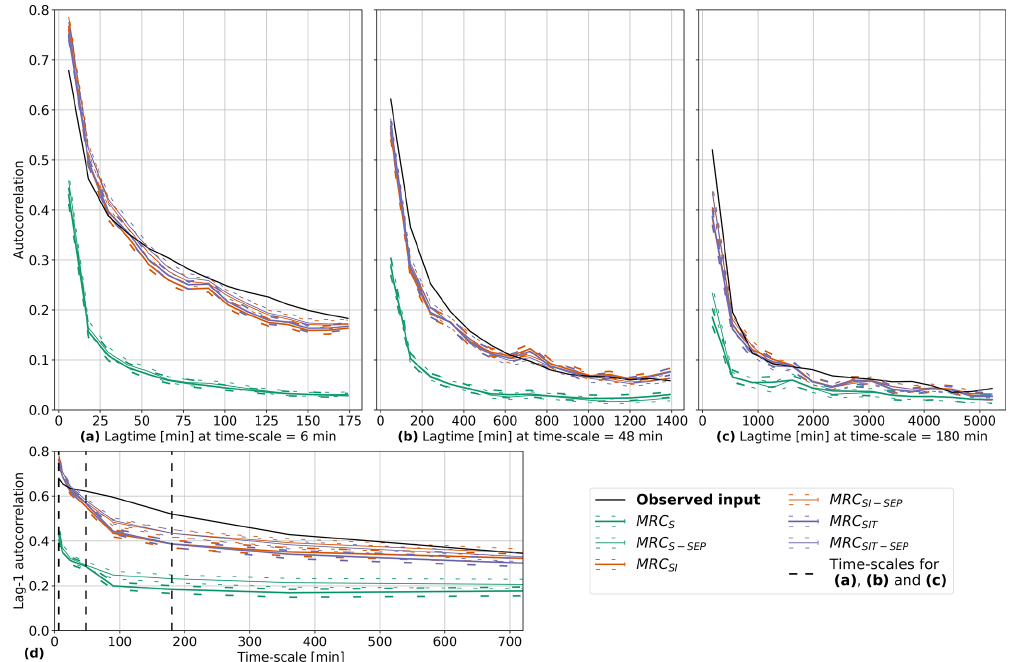
Figure 5. Autocorrelation with data from Bergen current climate for MRC S , MRC S-SEP , MRC SI , MRC SI-SEP , MRC SIT , and MRC SIT-SEP with a range from 5th to 95th percentiles. Autocorrelation with different lags for 6, 48, and 180min timescales, and lag-1 autocorrelation depending on timescale. They are compared to the observed input which represents the fine-resolution observed time series.